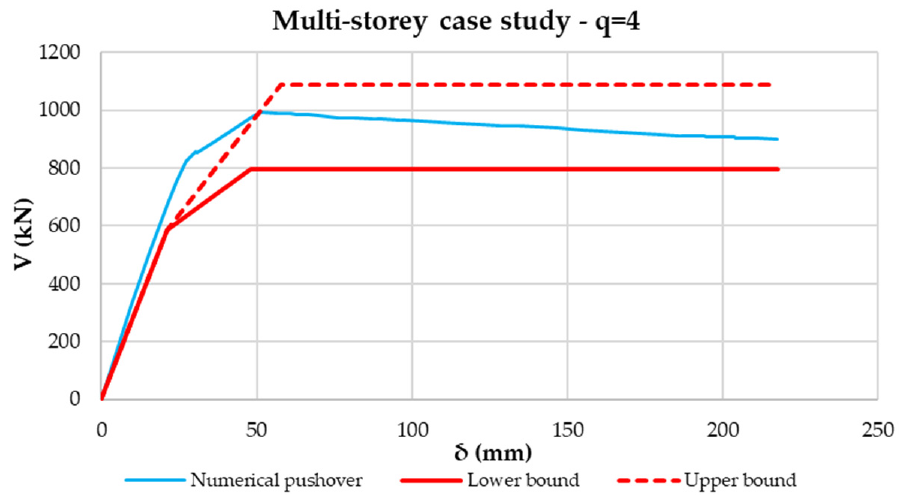
Figure 25. Comparison between numerical pushover curve and analytical spindle for the multi-storey building case study with structure factor equal to 4.